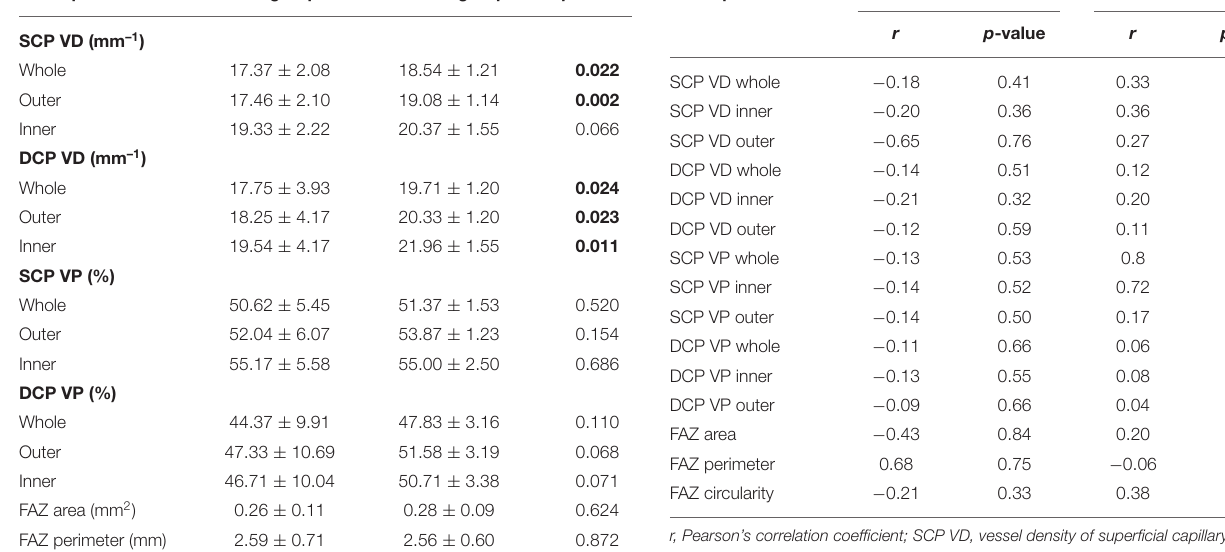
TABLE 2 | Differences in OCTA parameters between patients with Fabry disease and healthy controls. OCTA parameter FD group Control group